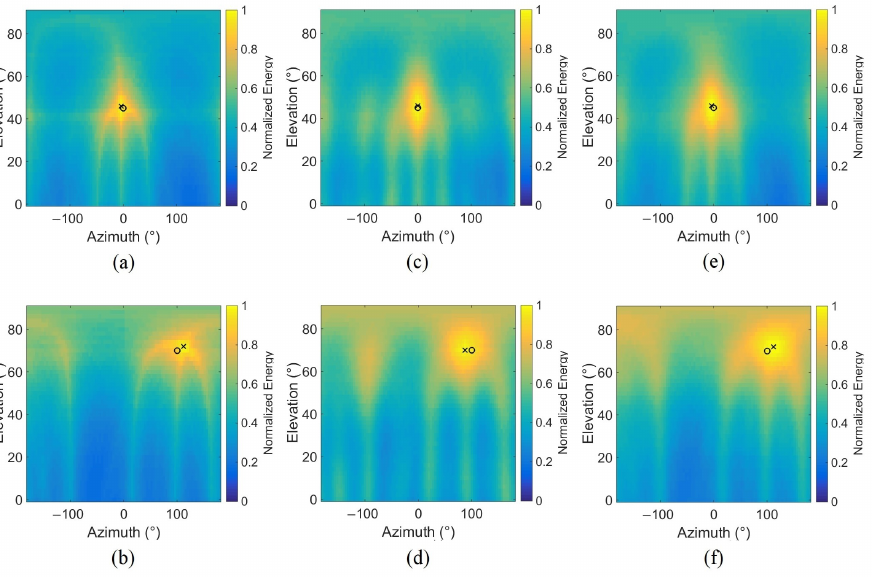
Figure 5. Normalized energy in the azimuth/elevation plane as a function of the position of the source [(0°, 45°) left, (100°, 70°) right], the method and the simulation technique used, ( a , b ): classical DSB, model; ( c , d ): classical DSB, real drone signal; ( e , f ): TFR, model (the circle represents the actual position of the virtual source, the cross represents the maximum energy